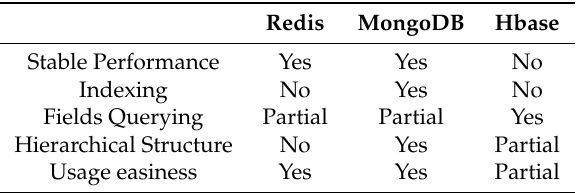
Table 2. Comparison of NoSQL